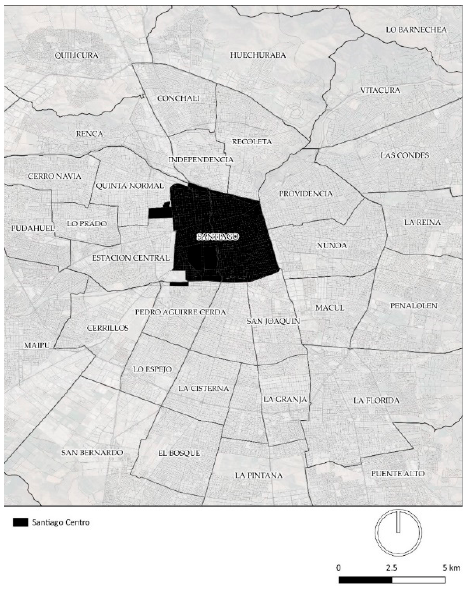
Figure 2. Santiago’s borough within the greater Santiago. Source: prepared and mapped by authors based on data from Instituto Nacional de Estadísticas [7].